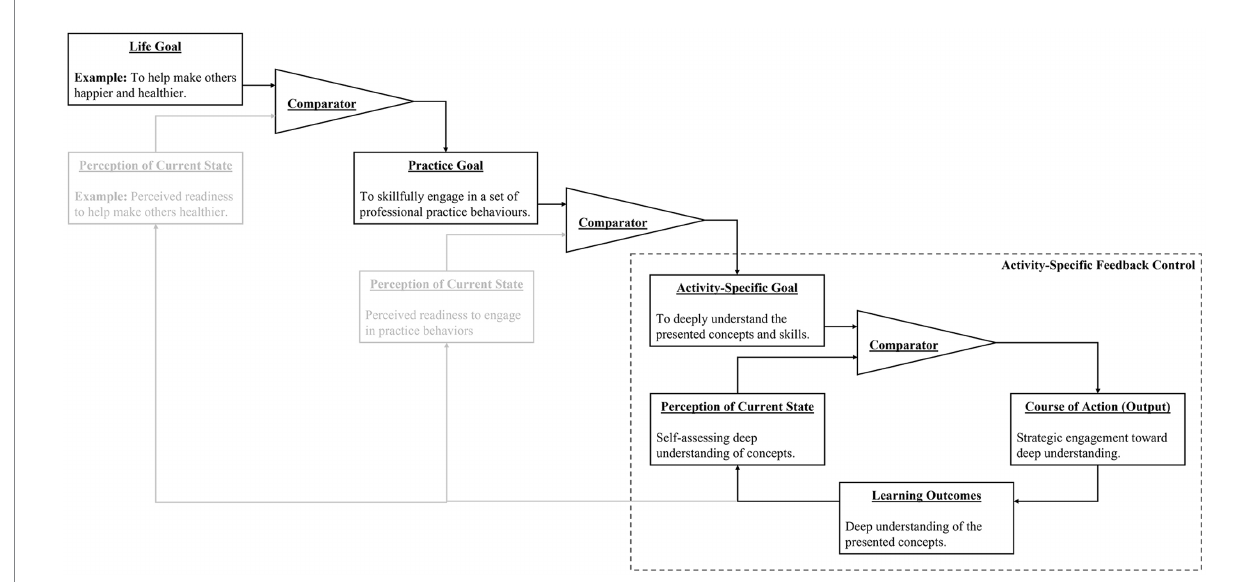
FIGURE 3 Proposed relationships between life goal framing, goal setting, and engagement [adapted from Carver (2015), with